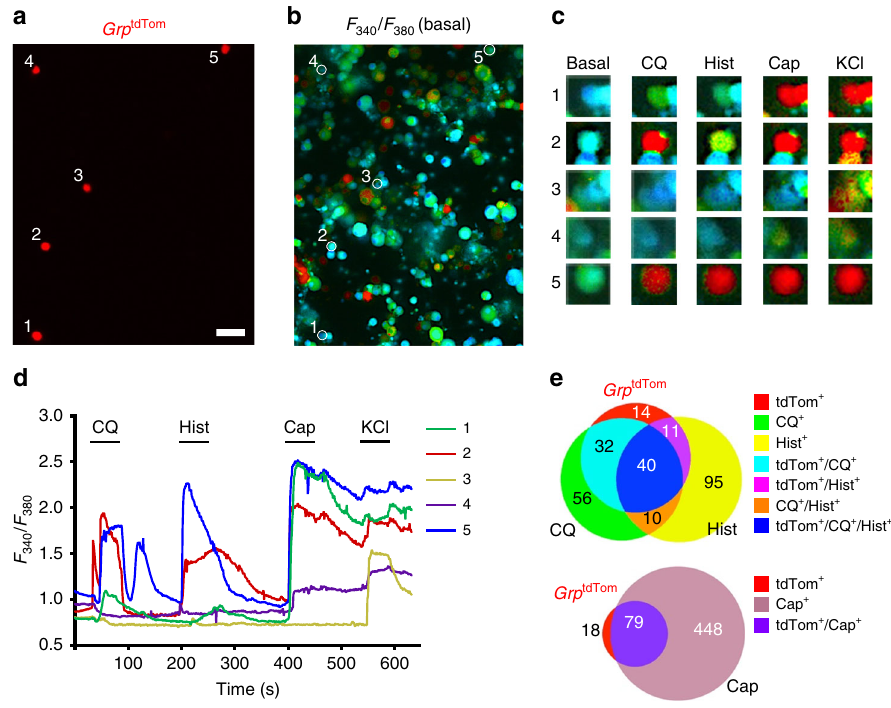
Fig. 4 Pruritogens induce Ca 2 + responses in Grp + sensory neurons. a and b Image of tdTomato neurons ( a ) and F 340 / F 380 signal ( b ) from Grp tdTom DRG cultures loaded with fura 2-AM. Scale bar, 50 μ m. c Snapshots of Grp tdTom neuron intracellular Ca 2 + levels at basal and 20 s after CQ (1 mM), Hist (100 μ M), Cap (100 nM) or KCl (30 mM) applications. d F 340 / F 380 traces from individual Grp tdTom neurons with application of CQ, Hist, Cap and KCl. e Venn diagram of Grp tdTom DRG neurons responsive to CQ, Hist or Cap and/or expressing tdTomato. n = 4 mice and 1424 neurons for a – e . Source data are provided as a Source Data fi